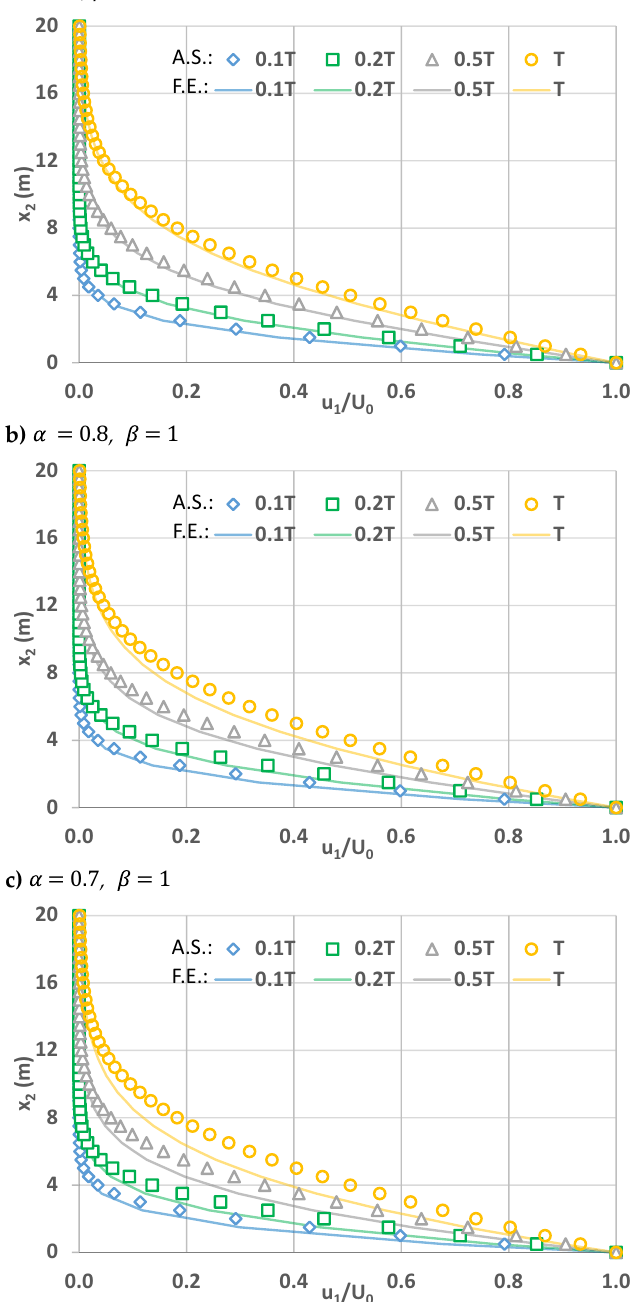
Figure 6. Velocity profiles of x 1 direction velocity u1 normalized by boundary velocity U 0 when space and time fractional derivative powers when β = 1 and ( a ) α = 0.9, ( b ) α = 0.8, ( c ) α = 0.7. Solid lines correspond to simulations by the fractional governing equation (F.E.) when time t = 0.1 T, 0.2 T, 0.5 T¸ T. Shapes (diamond, square, triangle, and circle) represent the analytical solutions (A.S.) of the conventional governing equation at corresponding